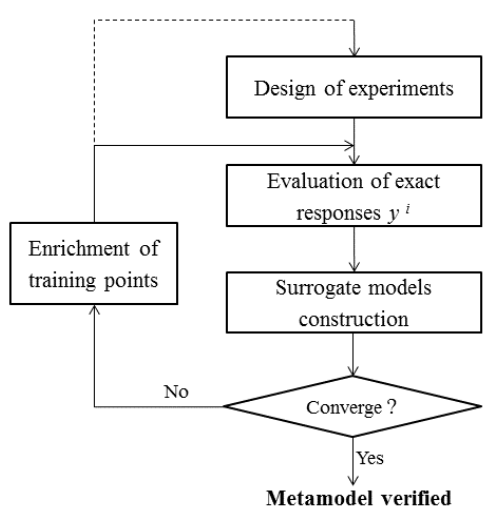
Figure 3. Flowchart of surrogate models